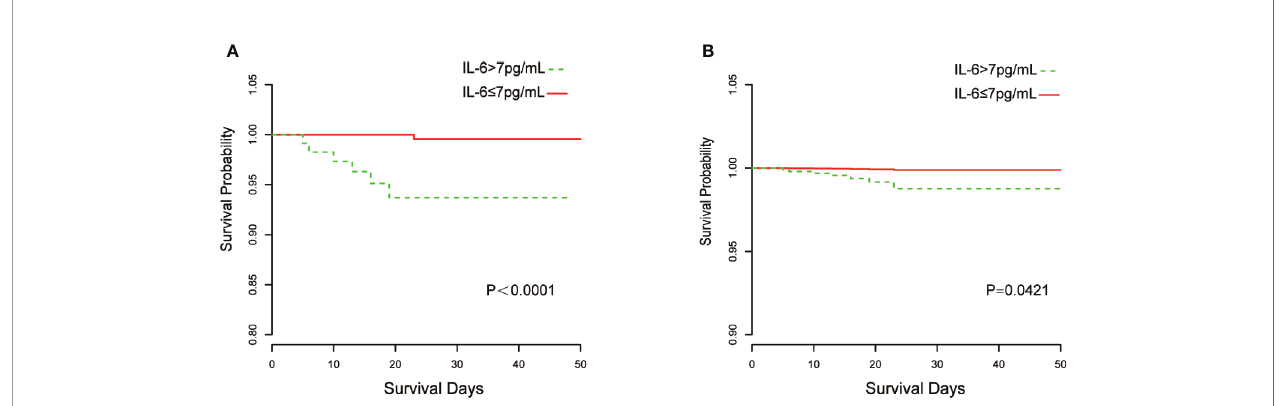
FIGURE 1 | Kaplan-Meier curves of IL-6 group strati fi cation for survival. (A) Without adjustment; (B) Adjusted for age, the history of cardiovascular disease, lymphocyte count, D-dimer, and lactate